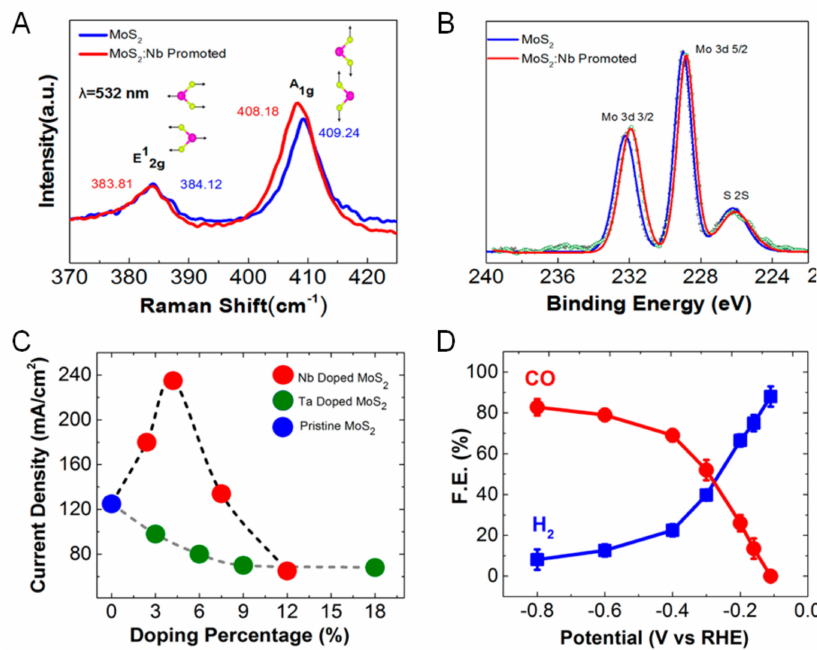
Figure 3. ( A ) Raman spectra and ( B ) XPS analyses of pristine MoS 2 and MoS 2 : Nb; ( C ) current densities of di ff erent samples with respect to doping percentage, and ( D ) faradaic e ffi ciencies (FE) of CO and H 2 formation at di ff erent applied potentials. Reprinted with permission from [57].